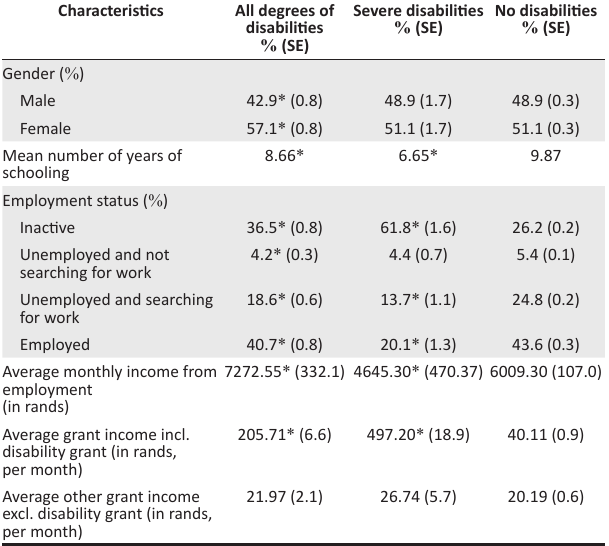
TABLE 2: Individual characteristics of people aged 15–59 years. Characteristics